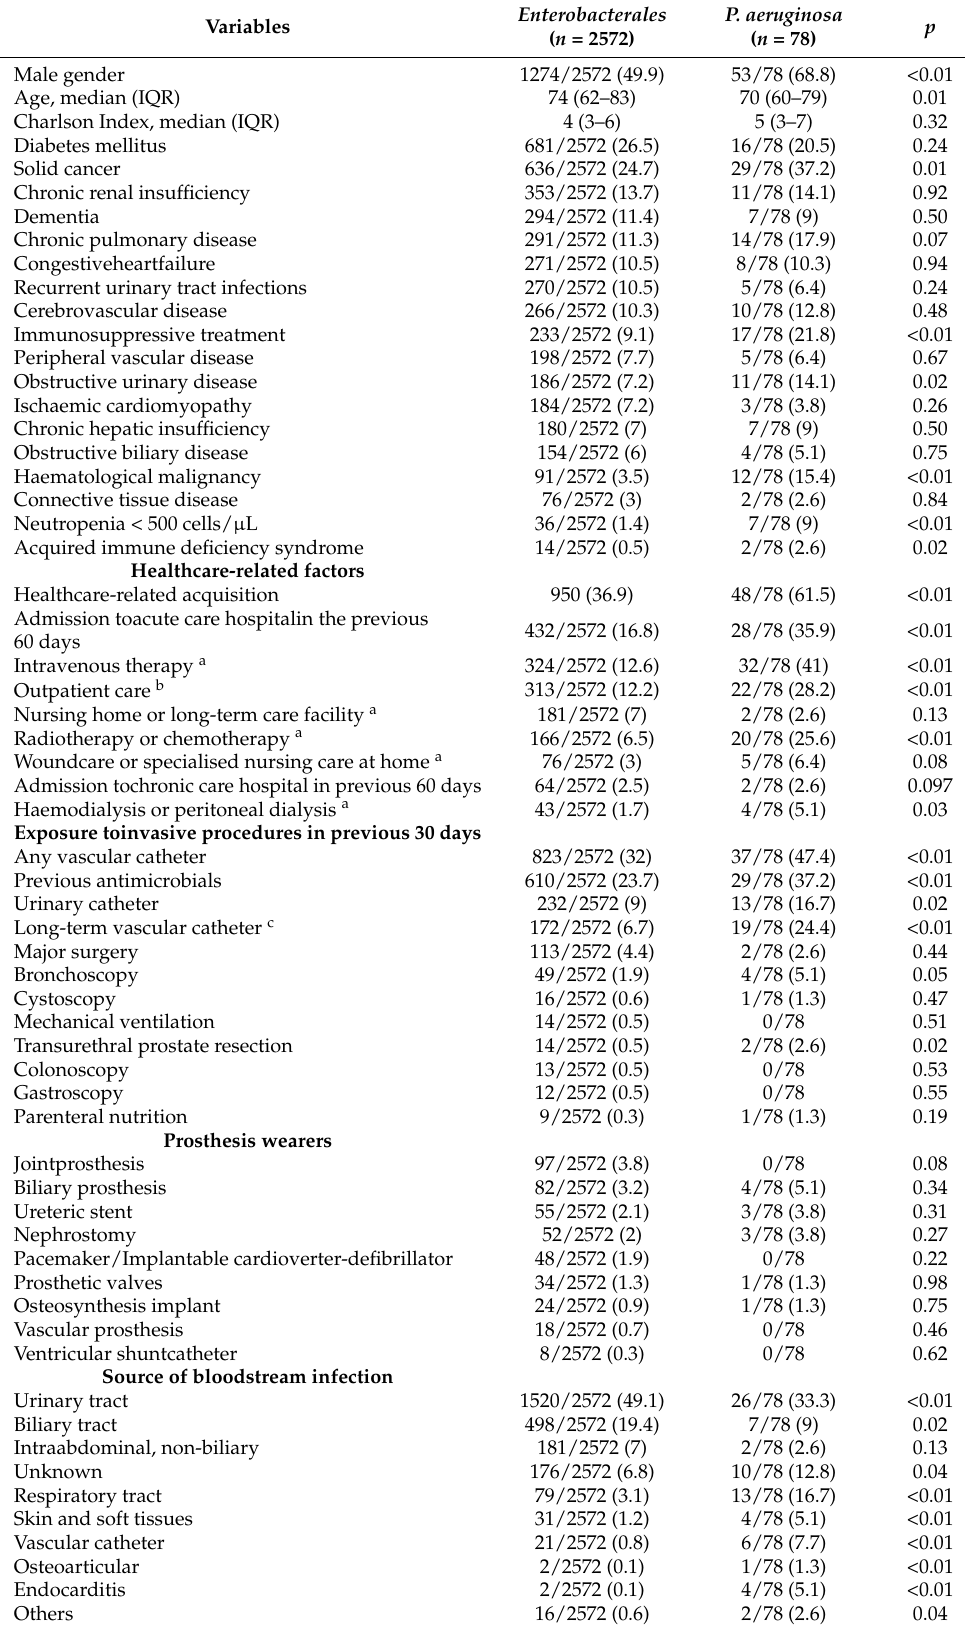
Table 1. Patient characteristics, comorbidities, exposure to invasive procedures in the previous 30 days and prosthesis wearers. Data are numbers (%) of cases, except where